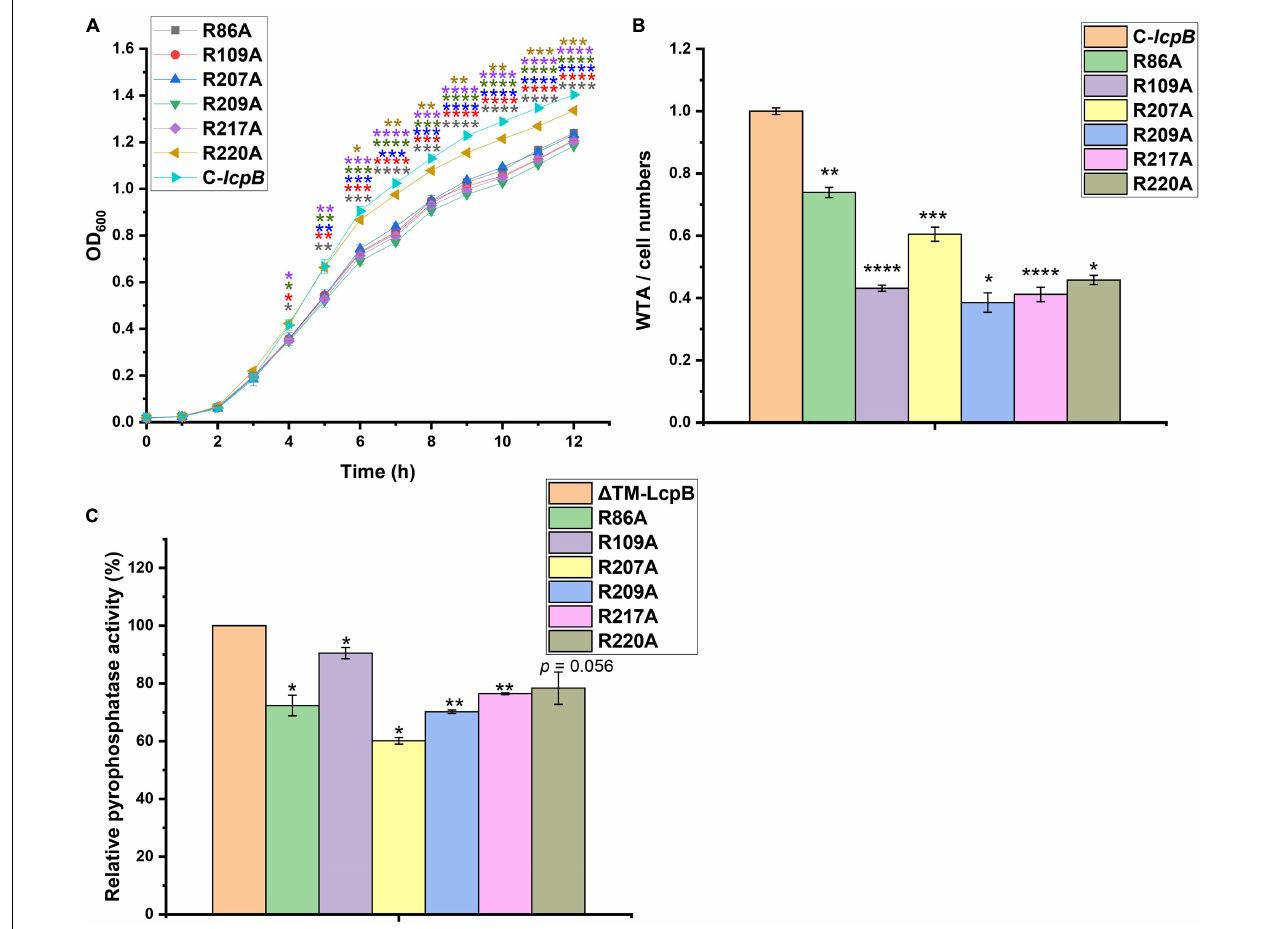
FIGURE 3 | Contributions of LcpB arginine sites in the LCP domain to pyrophosphatase activity and WTA synthesis. (A) Growth of strains with single arginine mutations in the LCP domain and non-mutant complemented strains. The results were obtained from three independent experiments performed in triplicates. Data is presented as mean ± standard deviation. Two-tailed Student’s t -test is used for the comparison of statistical significance. * p < 0.05; ** p < 0.01; *** p < 0.001; **** p < 0.0001. (B) Quantification of WTA in strains with single arginine mutation in the LCP domain and non-mutant complemented strains. At least three independent experiments were performed for each assay, after which the means and standard deviations were calculated. Data is presented as mean ± standard deviation. Two-tailed Student’s t -test is used for the comparison of statistical significance. * p < 0.05; ** p < 0.01; *** p < 0.001; **** p < 0.0001. (C) Comparison of the pyrophosphatase activity of (cid:49) TM-LcpB and (cid:49) TM-LcpB with a single arginine mutation. Four microgram protein was incubated with 2 µ mol FPP for 1 h at 30 ◦ C. The results were obtained from three independent experiments performed in triplicates, after which the means and standard deviations were calculated. Data is presented as the mean ± standard deviation. Two-tailed Student’s t -test is used for the comparison of statistical significance. * p < 0.05; ** p <